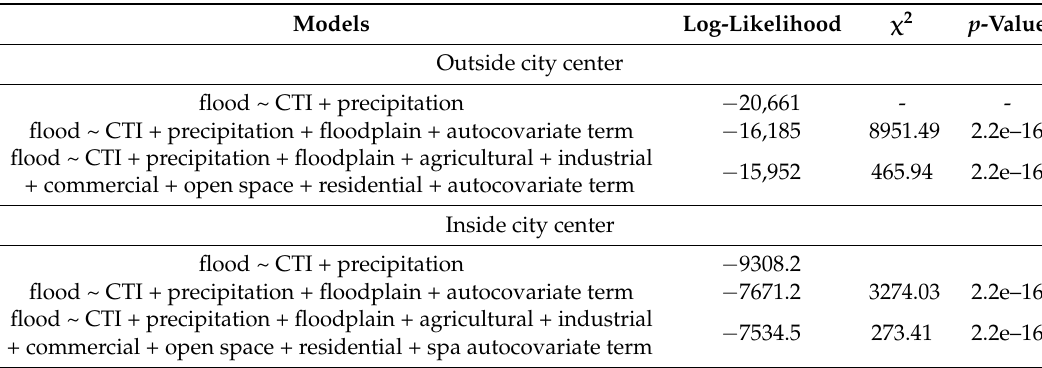
Table 1. Model comparisons for tests of the driving factors influencing the occurrences of flooding events in Hurricane Harvey.